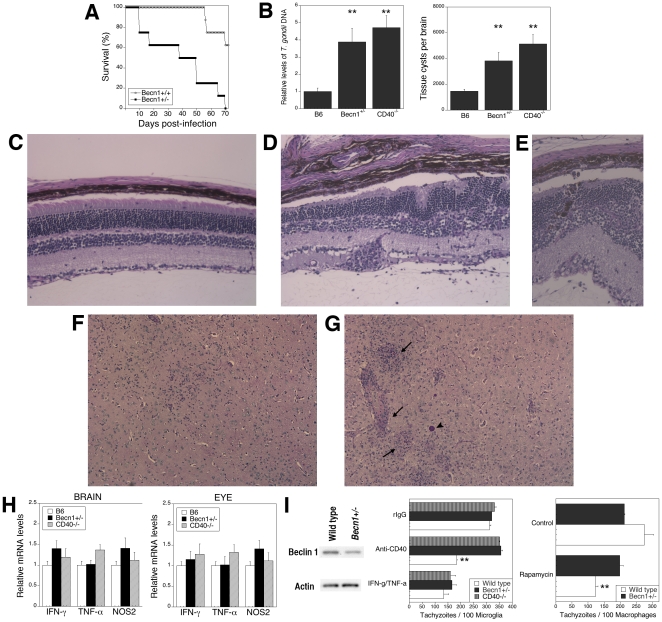
Autophagy-deficient mice are susceptible to cerebral and ocular toxoplasmosis.
Becn1
+/− and littermate control mice (B6) were infected with ME49 T. gondii. A, Survival was monitored daily. Data shown are from groups containing 8 mice. B, Mice (5 mice per group) were euthanized at 4 weeks post-infection. DNA was isolated from eyes and the levels of the T. gondii B1 gene were examined using real time quantitative PCR. Tissue cysts were counted in brain homogenates. C, Eyes from infected control mice revealed mild histopathology. D, E, Eyes from infected Becn1
+/− mice revealed disruption of retinal architecture, more prominent inflammation and invasion of the retina by retinal pigmented epithelial cells (E). PASH; X200. F, Brains from infected control mice showed slight inflammation. G, Brains from infected Becn1
+/− mice show prominent areas of inflammation (arrow) and frequent tissue cysts (arrow head). PASH X100. H, Levels of IFN-γ, TNF-α and NOS2 mRNA in eyes and brains were examined using real time quantitative PCR and normalized against the levels of 18s rRNA. Each group contained 5 mice. I, Beclin 1 and actin protein expression in primary microglia from control and Becn1
+/− mice. Primary brain microglia from control and Becn1
+/− mice and were incubated with anti-CD40 or control mAb, or with IFN-γ/TNF-α followed by infection with tachyzoites of RH T. gondii. Primary bone marrow derived macrophages were obtained from control and Becn1
+/− mice and were incubated with or without rapamycin (1 µM) 2 h after infection with tachyzoites of RH T. gondii. Results are shown as the mean ± SEM and are representative of 3 independent experiments. **p≤0.01.